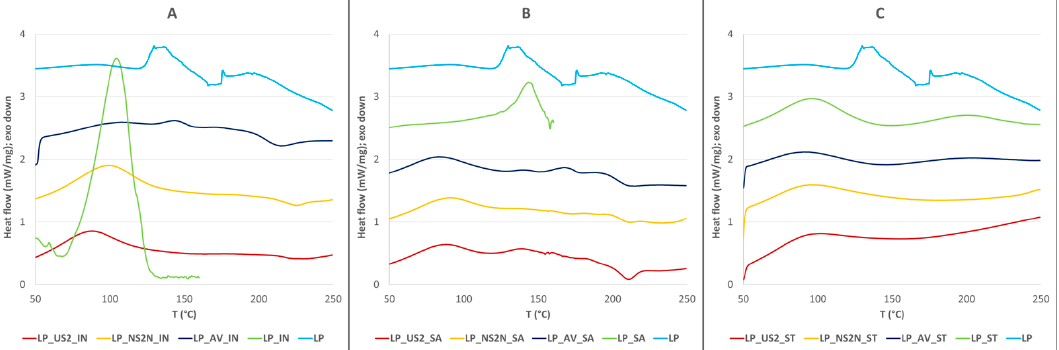
Figure 2. DSC plots of lyophilized samples with different cryoprotectants compared with a pure lyophilized sample: ( A ) IN; ( B ) SA; and ( C )